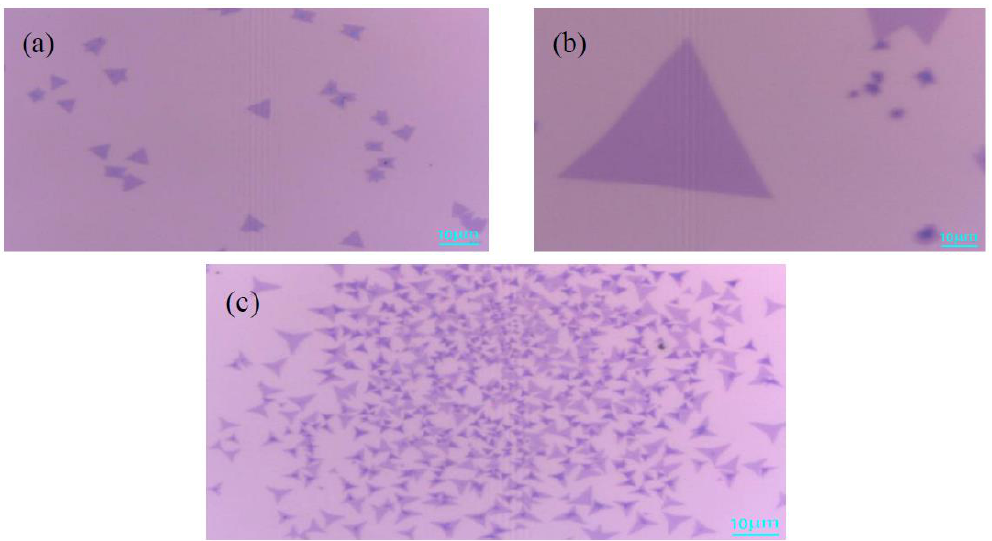
Figure 2. Optical microscope images of MoS 2 grown at different temperatures ( a ) 670 ◦ C; ( b ) 720 ◦ C; ( c ) 770 ◦ C. Scale bar: 10 µ m.